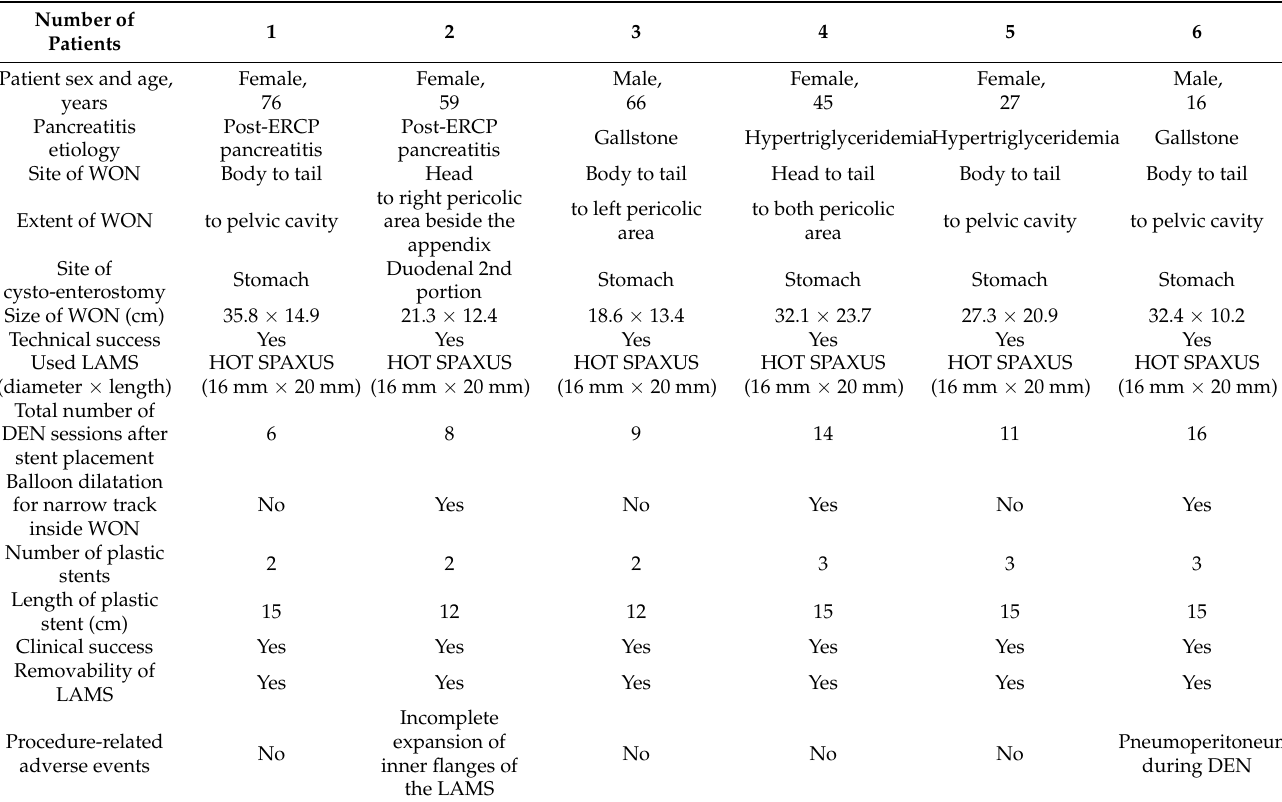
Table 1. Baseline characteristics of the included